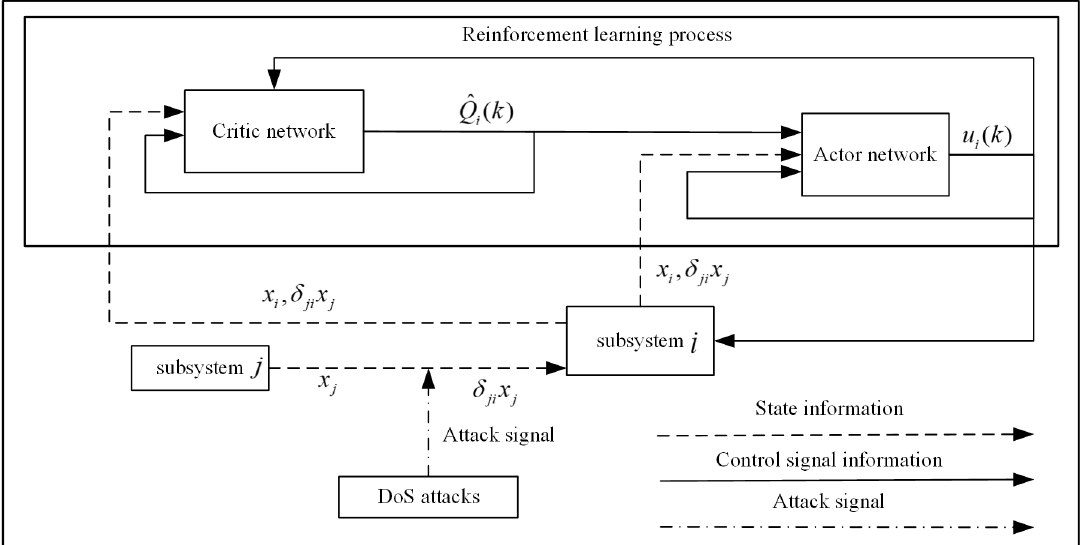
Figure 2. The overall work-flow of the power grid control